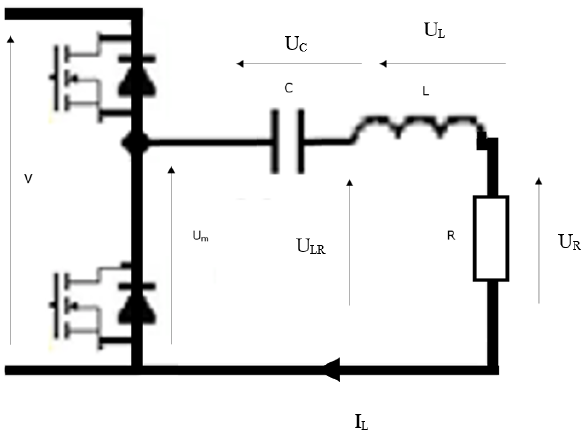
Figure 5. RLC series test bench.